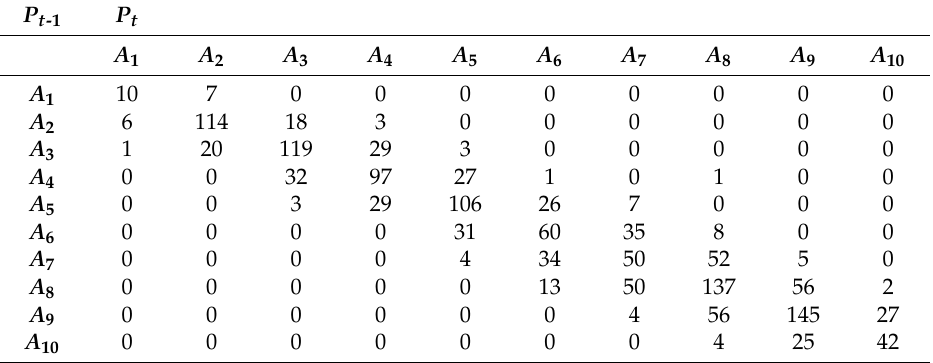
Table 4. Fuzzy relationship groups and weight matrix before standardization.